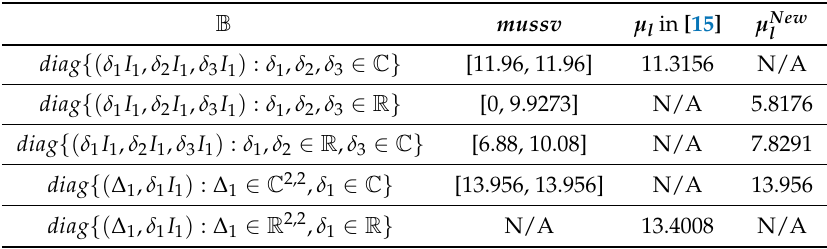
Table 3. Numerical approximation of bounds of